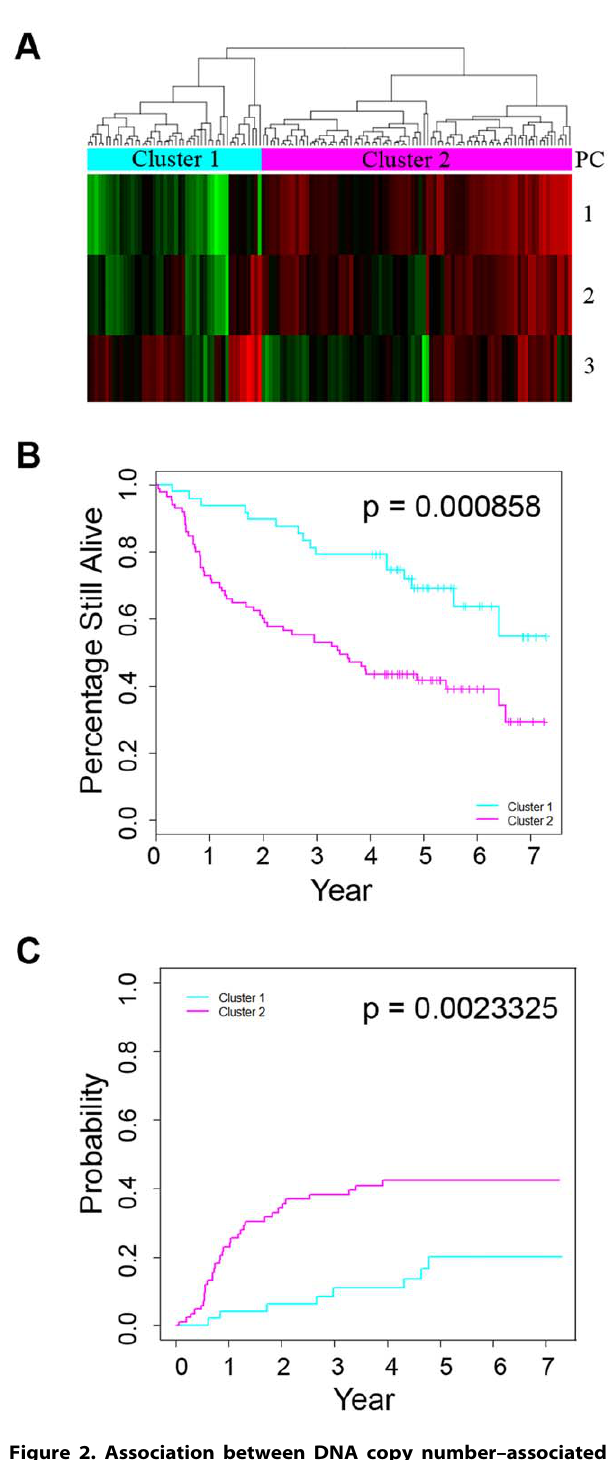
Figure 2. Association between DNA copy number–associated differentially expressed genes and survival. A) Hierarchical clustering of an independent dataset of 133 patients using the 95 CNA-associated differentially-expressed gene signature. Expression variances of the genes were summarized by principal components analysis. A hierarchical clustering analysis was performed using the first three principal component (PC) scores; B) Overall survival of the two patient clusters stratified by the 95-CNA-associated differentially expressed signature; C) Cumulative incidence of OSCC-specific death for the two patient